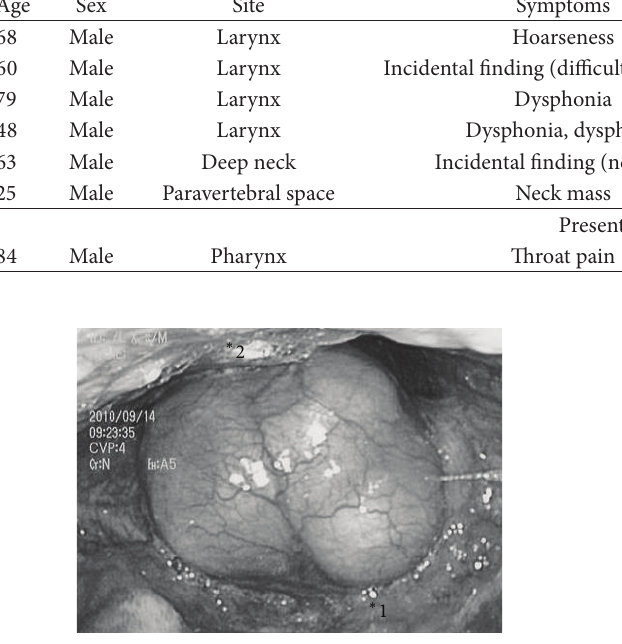
Figure 1: Endoscopic examination of the pharynx. ∗ 1 : root of the tongue; ∗ 2 : posterior wall of the